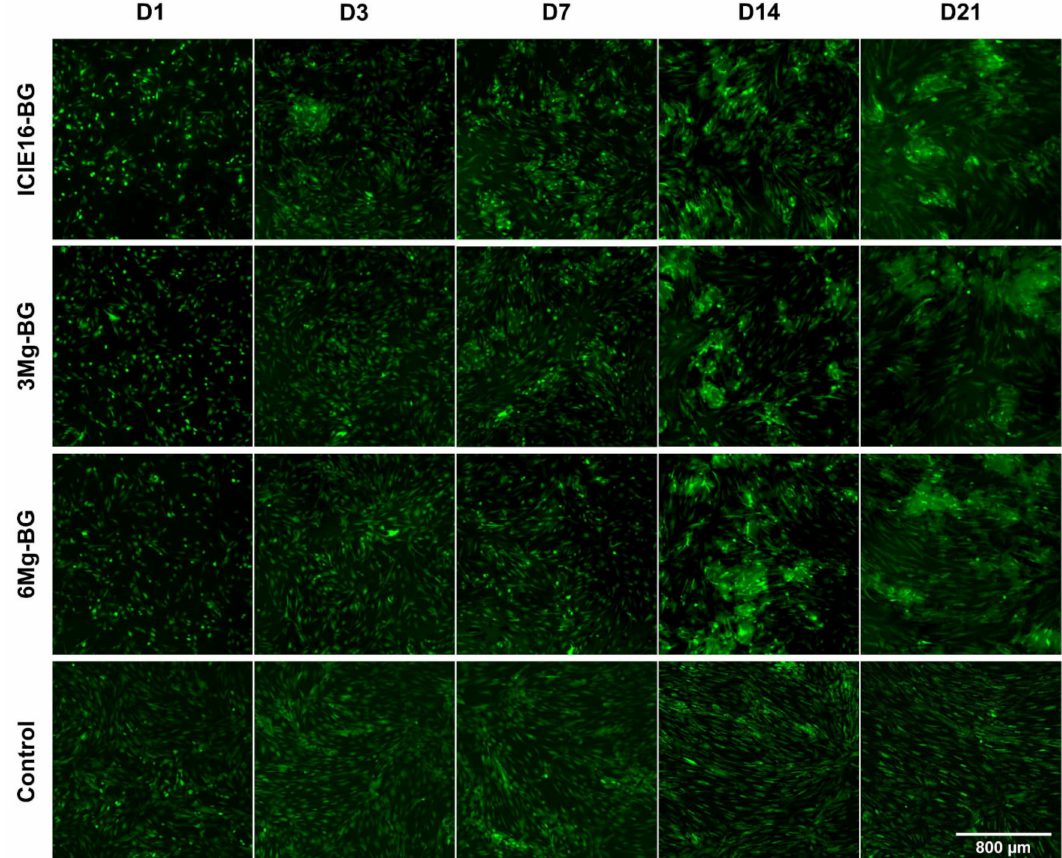
Figure 4. Microscopic presentation of cell viability and growth patterns during 21 days (D) of direct co-culture with bioactive glasses (BGs). Visualization occurred via a live-cell fluorescence staining using fluorescein diacetate (FDA). Magnification: 40-fold; the reference bar of 800 µ m applies to all